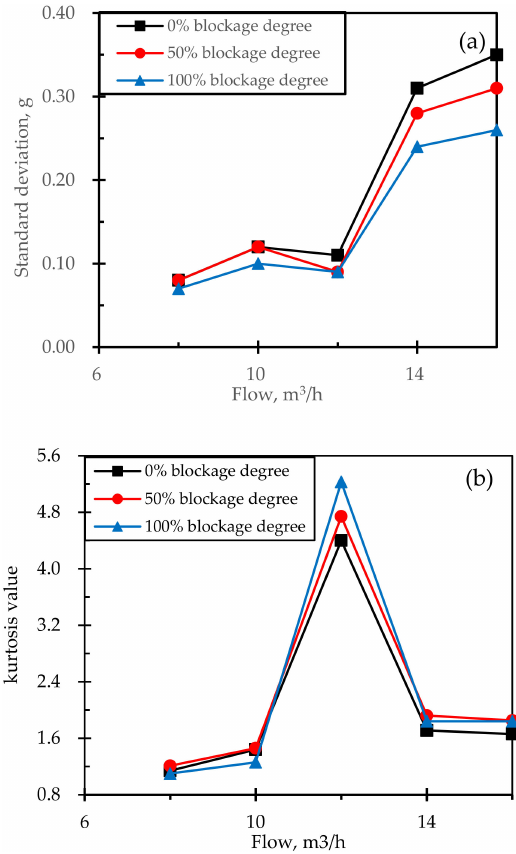
Figure 4. Distribution of ( a ) standard deviation and ( b ) kurtosis index of acceleration amplitude with increasing throughput under di ff erent blockage